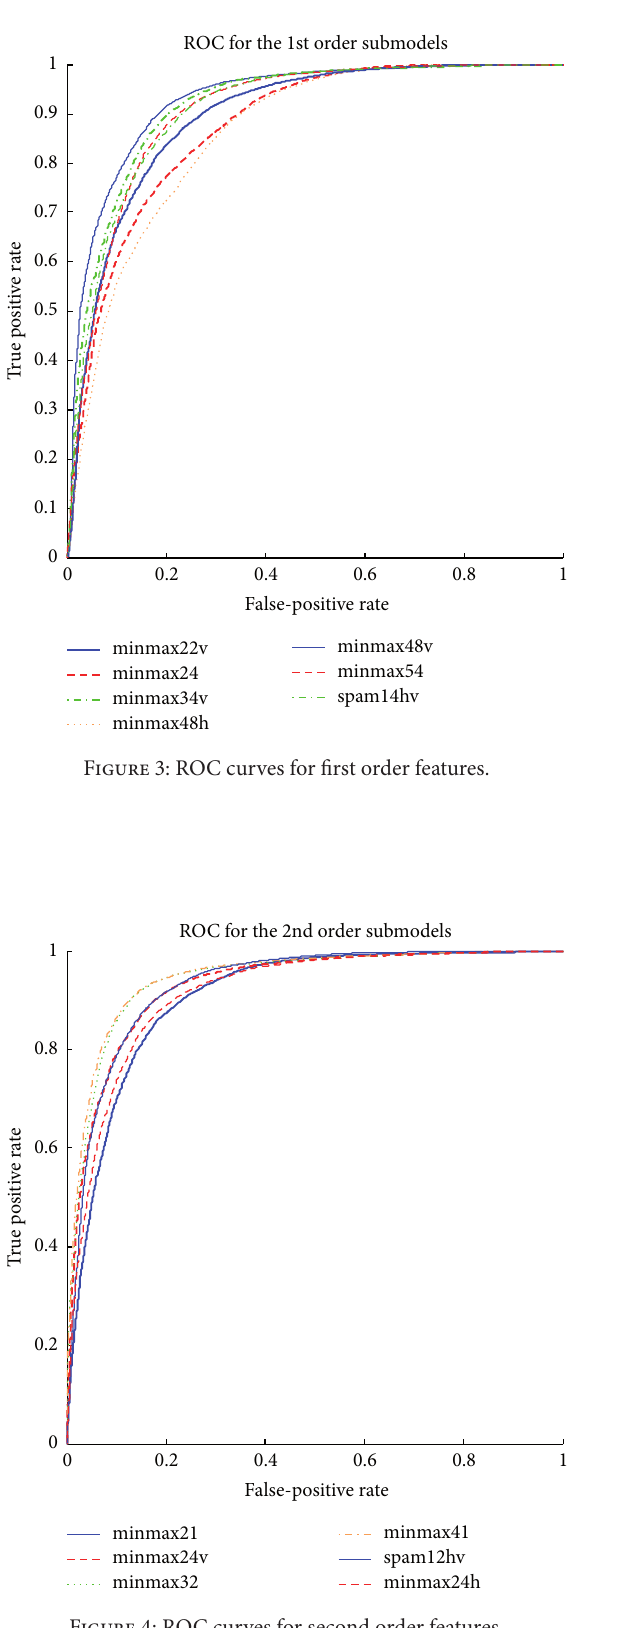
Figure 6: ROC curves for EDGE3 × 3